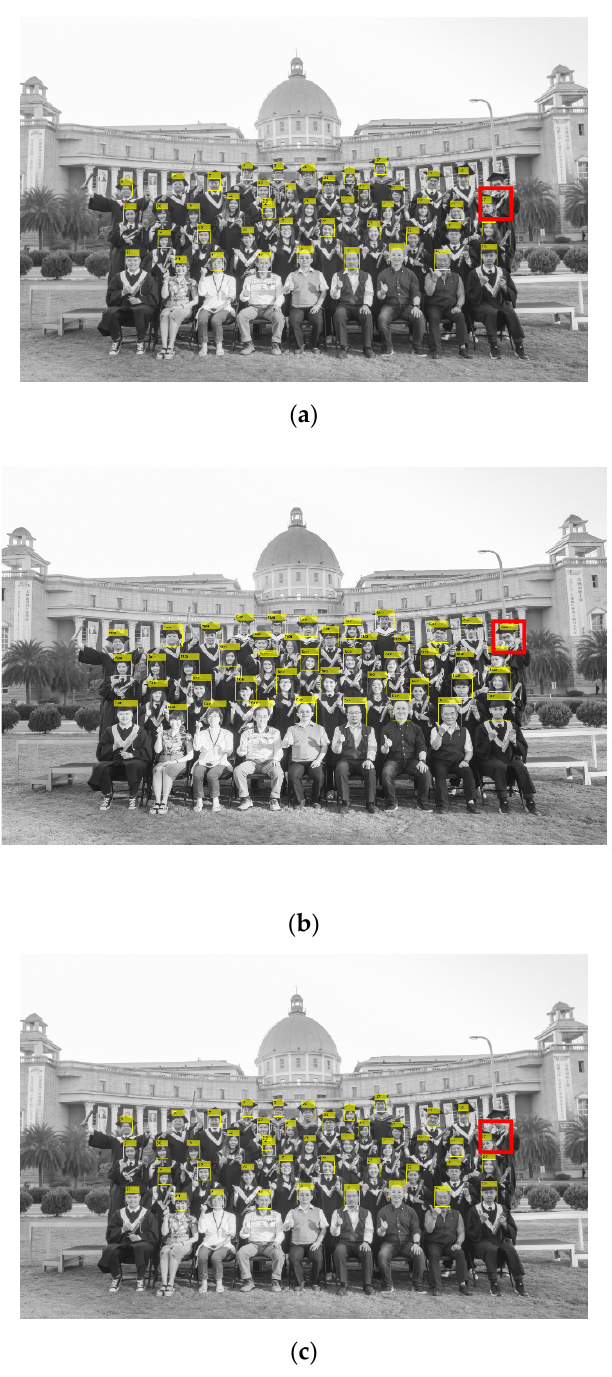
Figure 7. Comparisons of people calculating results: ( a ) using the VJ algorithm with merging threshold = 2; ( b ) using the YOLOv4 network; ( c ) using the proposed method.